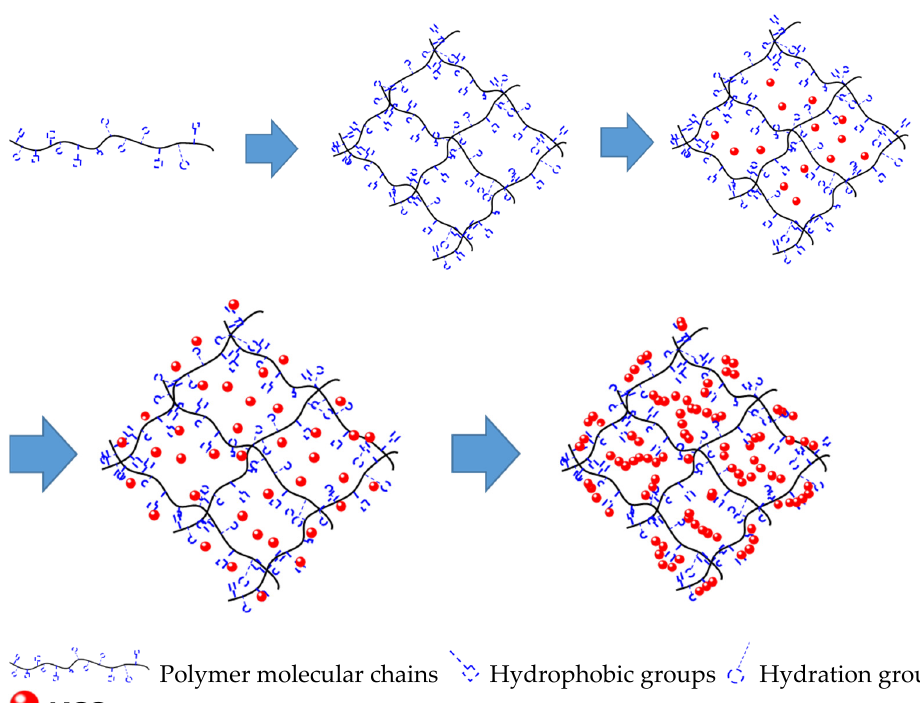
Figure 2. Schematic diagram of PAASM-CaCO 3 reaction. An amount of 30 mL of sodium tetraborate buffer solution was prepared in beaker 1, and then 17.5 g of NCC was added. After high-speed stirring at 12,000 rpm for 15 min, 5 mL of dimethyl sulfoxide was added dropwise and placed in an ultrasonic cell disintegra- tor for dispersion. An amount of 50 mL of deionized water was added in beaker 2, and then 43.5 g of AMPS was added to dissolve with sufficient stirring. In beaker 3, 20 mL of deionized water was added and 29.8 g of AM was dissolved with stirring under heating.